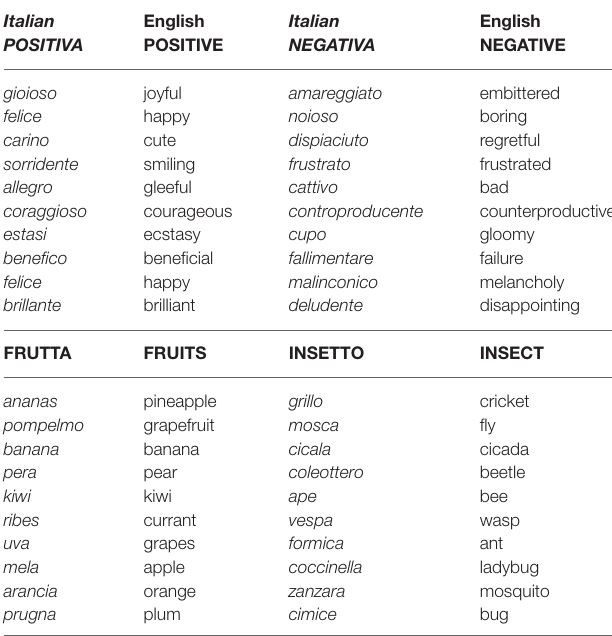
TABLE 1 | The 40 words used to generate the four experimental blocks (in Italian and English) are reported along with their category (POSITIVE, NEGATIVE, FRUITS, INSECTS).